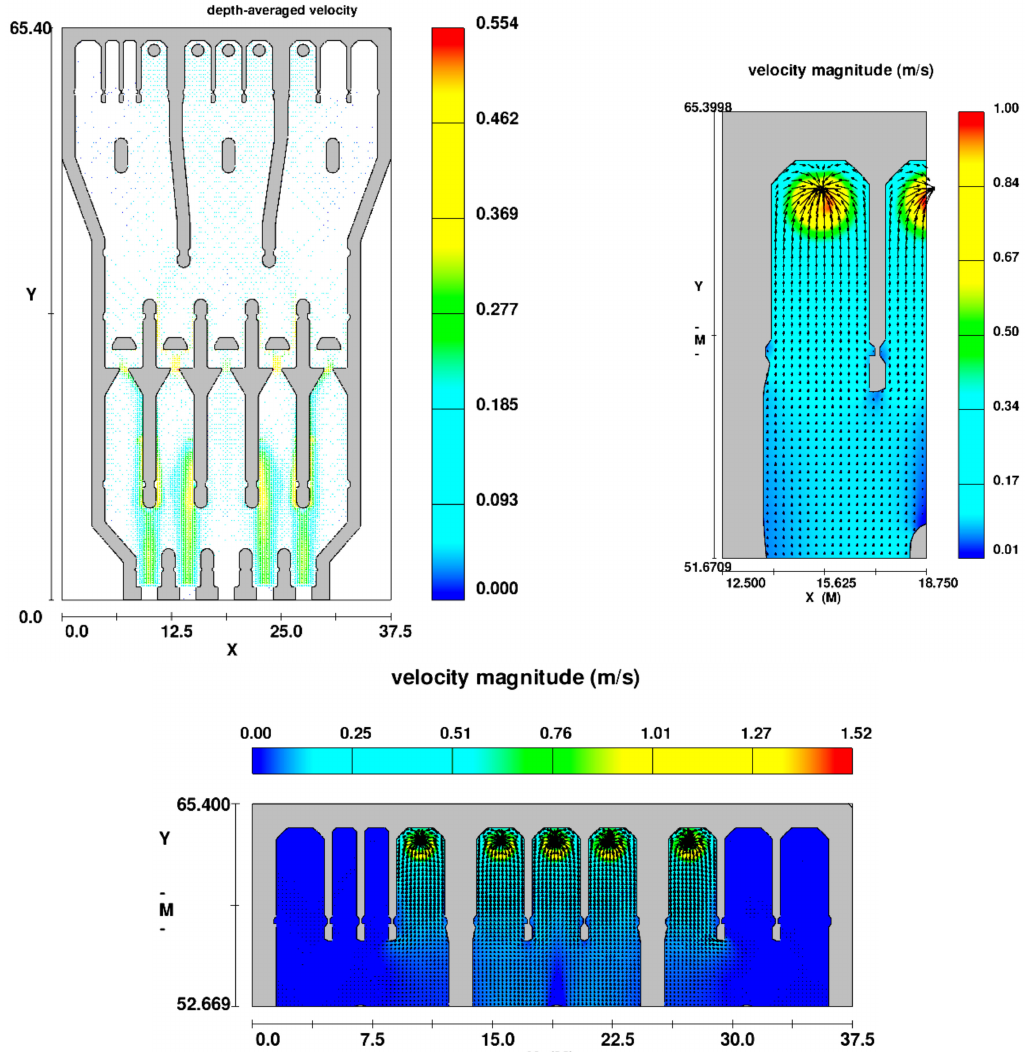
Figure 10. Field vector of velocity at the basin for scenario III—3D